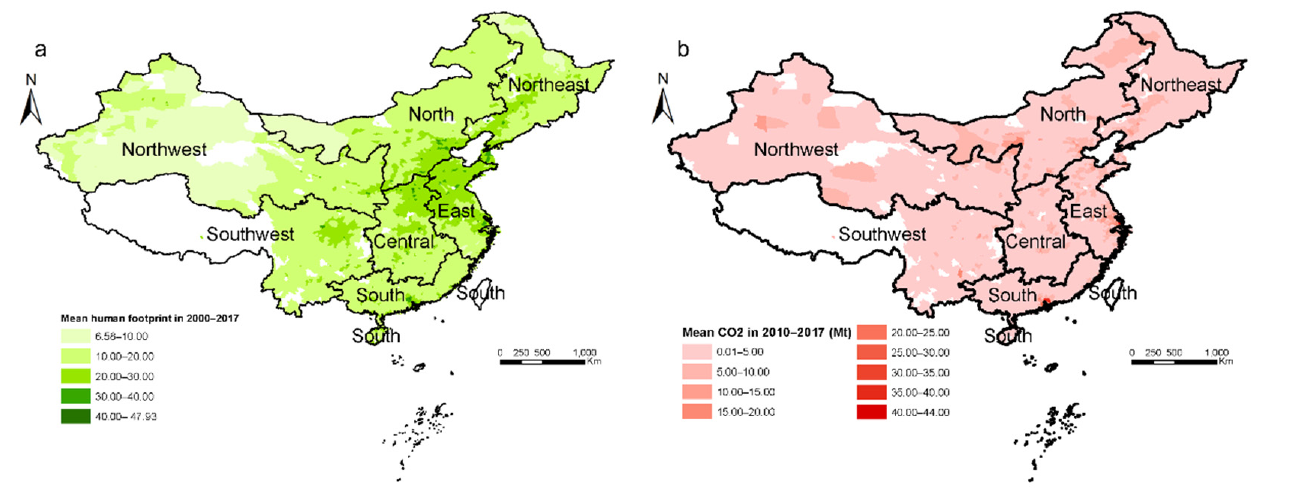
Figure 2. Spatial pattern of the average ( a ) human footprint and ( b ) CO 2 emissions in different regions in China during